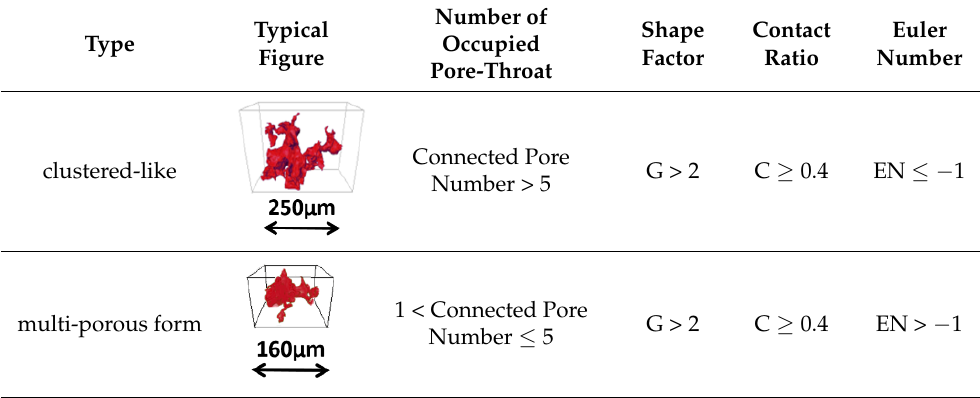
Table 5. Quantitative characterization of the microscopic remaining oil.